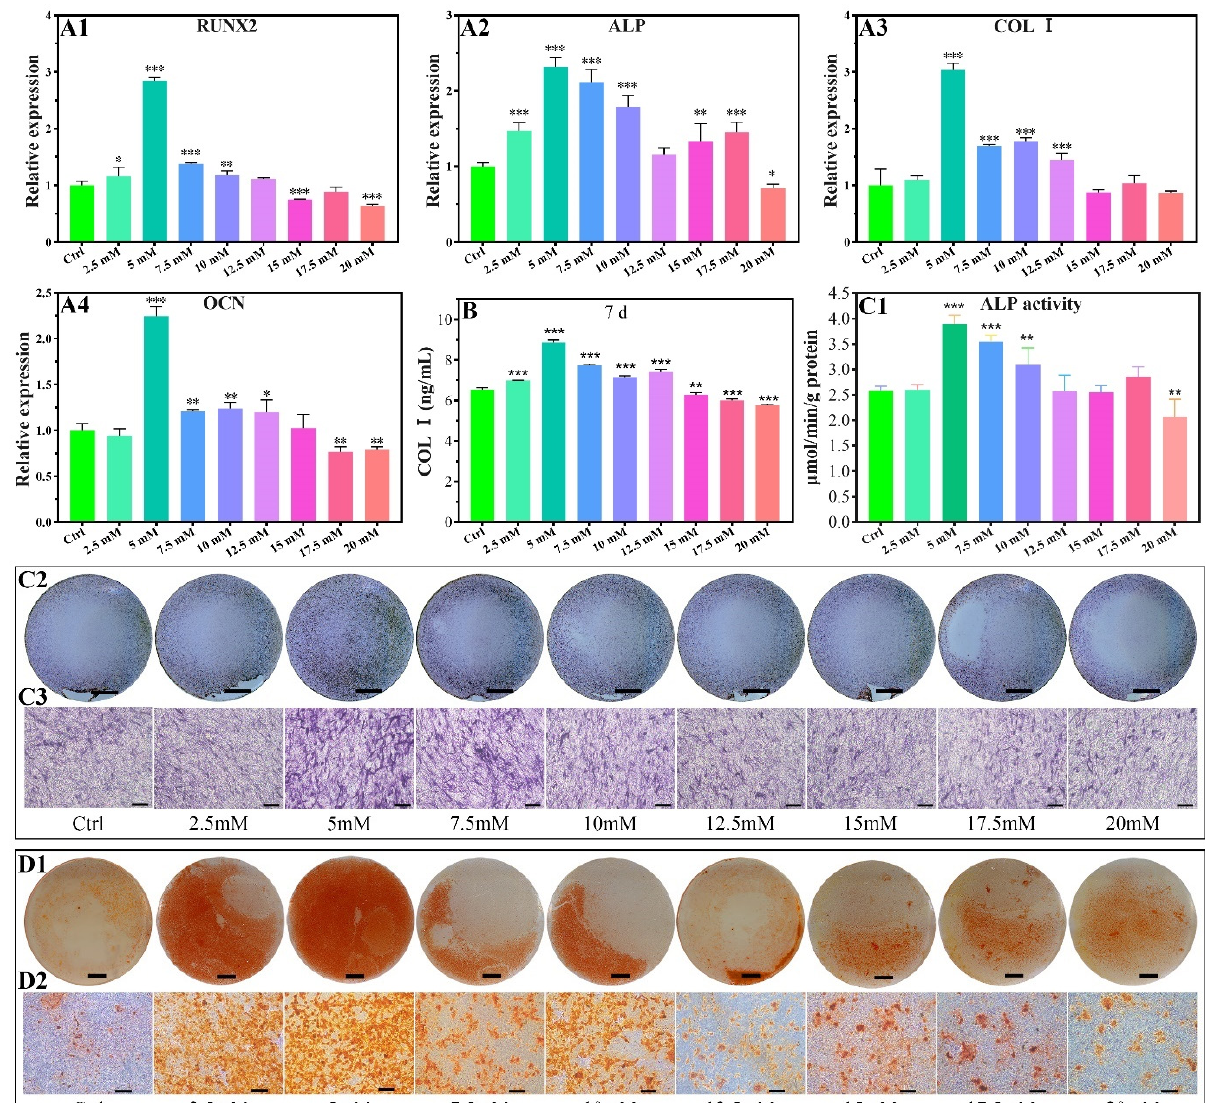
Figure 6. Osteogenic-related gene expressions of MC3T3-E1 cells cultured in different concentrations of Mg 2+ ( A1 – A4 ), all data are presented as fold change after normalization to GAPDH, and fold changes are shown as mean ± SD, * p < 0.05, ** p < 0.01, and *** p < 0.001. COL I contents of MC3T3-E1 cells after being cultured in varied Mg 2+ concentrations on the 7d by ELISA ( B ). ALP activity of MC3T3-E1 cells after being cultured in varied Mg 2+ concentrations on the 7d by quantitative ALP activity assay ( C1 ) and ALP activity staining assay ( C2 , C3 ). Effect of Mg 2+ concentrations on the formation of calcium nodules ( D1 , D2 ). The scale bars in C2, C3, D1, and D2 are 5 mm, 200 μ m, 5 mm, and 200 μ m, respectively.